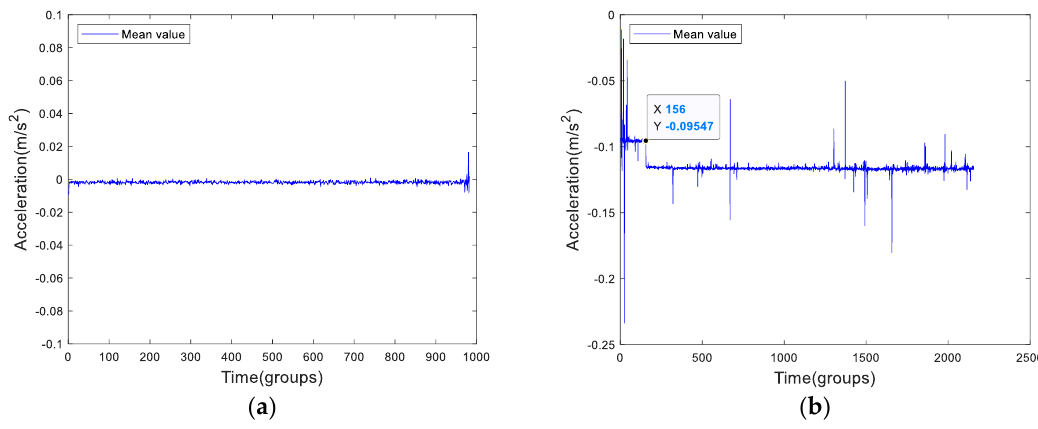
Figure 3. The mean value of ( a ) Bearing2-1IMS and ( b ) Bearing1-4IMS.